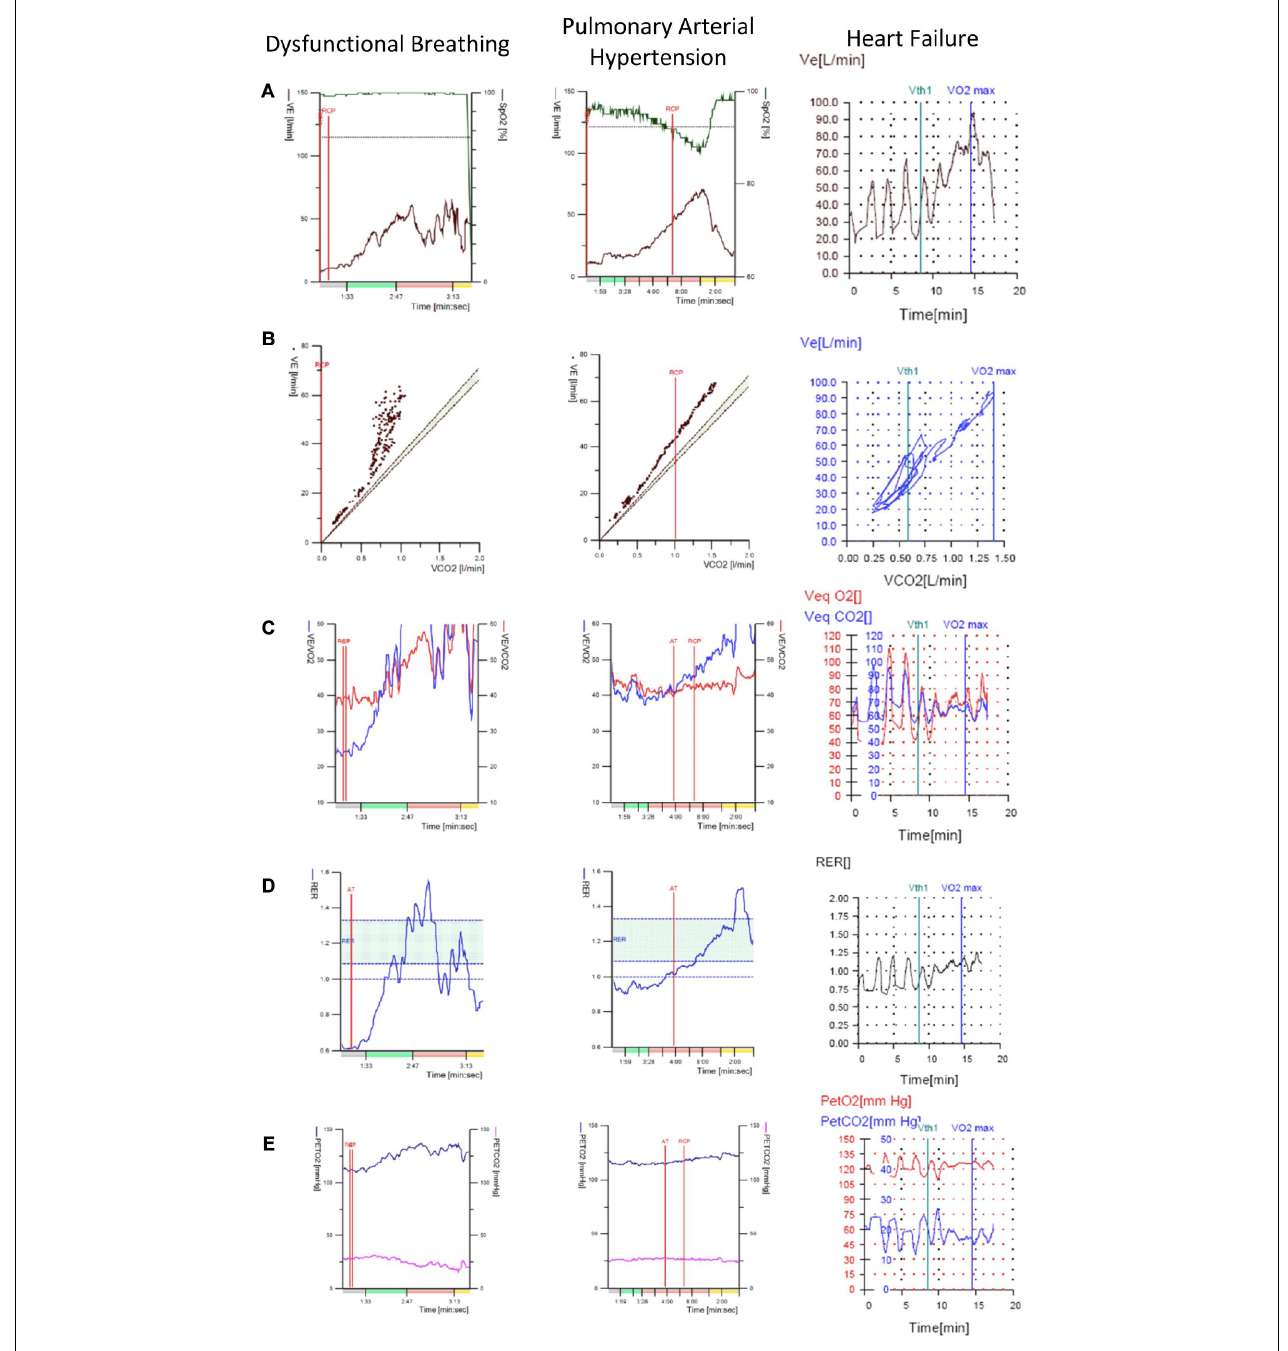
FIGURE 3 | Representative CPET plots that can be used to help distinguish between DB, pulmonary arterial hypertension and heart failure with periodic breathing. These conditions may be differentials in patients undergoing CPET for unexplained dyspnea suspected to be DB All three may present with seemingly erratic patterns of V t and B f responses to exercise. Therefore these plots can be used to narrow down the diagnosis when interpreting a CPET. Note that in columns 1 and 2 the colors on the x -axis indicate the phase of exercise; gray is rest, green is unloaded cycling red is linearly increasing workload and yellow is recovery. In the third column, unloaded cycling began at 2 min and loaded cycling at 5 min. (A) Plot of minute ventilation and oxygen saturation against time. (B) Plot of minute ventilation against volume of CO 2 exhaled per minute. (C) Plot of ventilatory equivalents for CO 2 and O 2 against time. (D) Plot of respiratory exchange ratio against time. (E) Plot of end-tidal CO 2 and O 2 against time. Particular points to take from this figure are the similarity in appearance of DB and pulmonary arterial hypertension plots. Major differences include the desaturation in pulmonary arterial hypertension and the fall in respiratory exchange ratio in later exercise in DB. Additionally, note the clear periodicity across the plots in the case of heart failure with periodic breathing; this is not the case for DB. V E , minute ventilation; SpO 2 , oxygen saturation; V E / V CO 2 or VeqCO 2 , ventilatory equivalent for CO 2 ; V E / V O 2 or VeqO 2 , ventilatory equivalent for O 2 ; P ET CO 2 , end-tidal CO 2 ; P ET O 2 , end-tidal O 2 ; RER, respiratory exchange ratio; RCP, respiratory compensation point; Vth1, first ventilatory threshold; VO 2 max, point of maximal O 2 consumption; AT, anaerobic threshold.